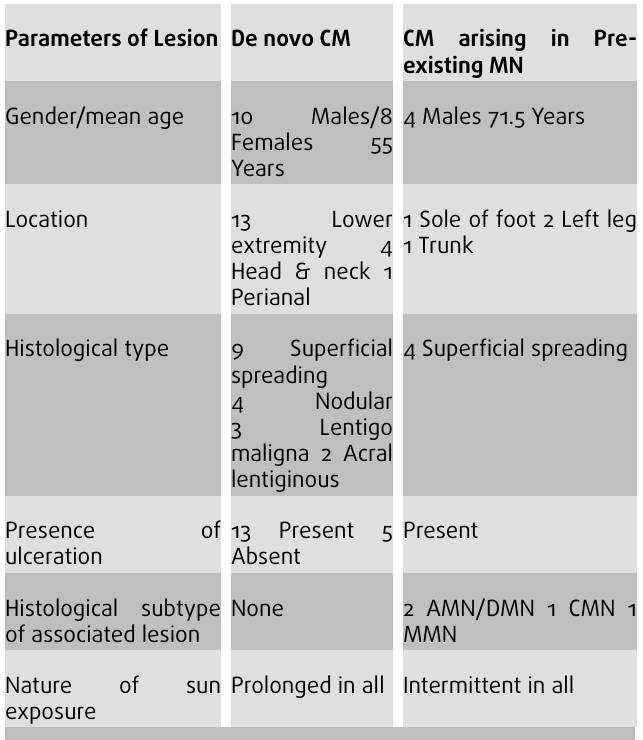
Table 5: Correlation of de novo CM and that arising from pre-existing MN among patients attending KAAUH between January 2000 and December 2017.